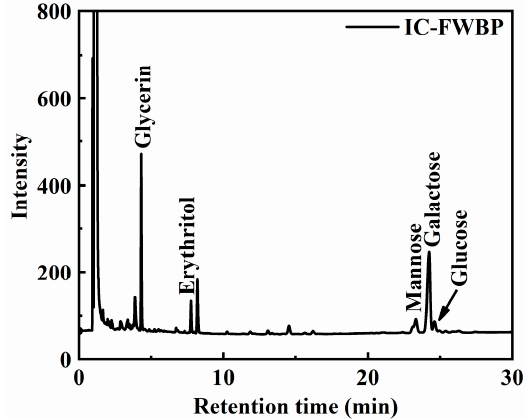
Figure 2. Gas chromatography of the Smith degradation of the IC-FWBP.